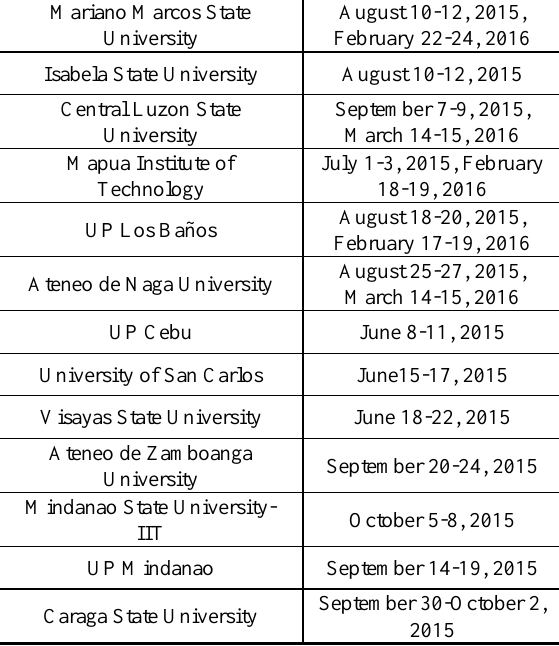
Table 2. Schedule of monitoring sessions